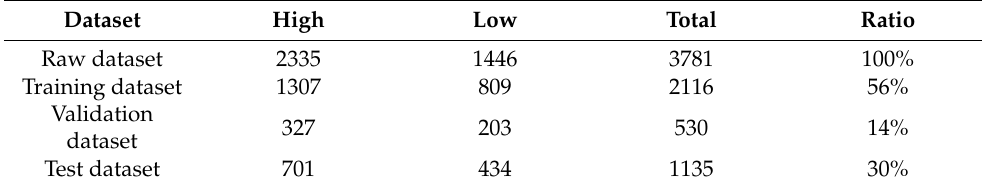
Table 3. Results of splitting the data to train the